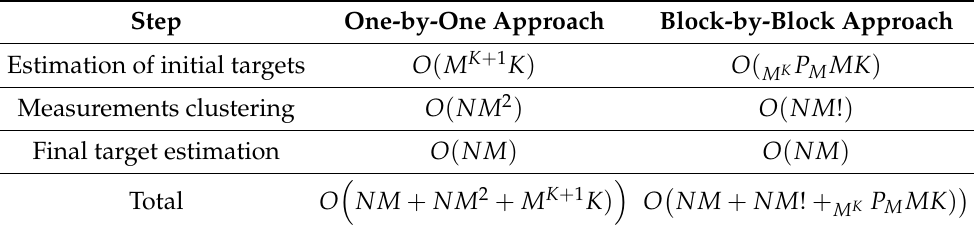
Table 1. Complexity of Proposed algorithm.